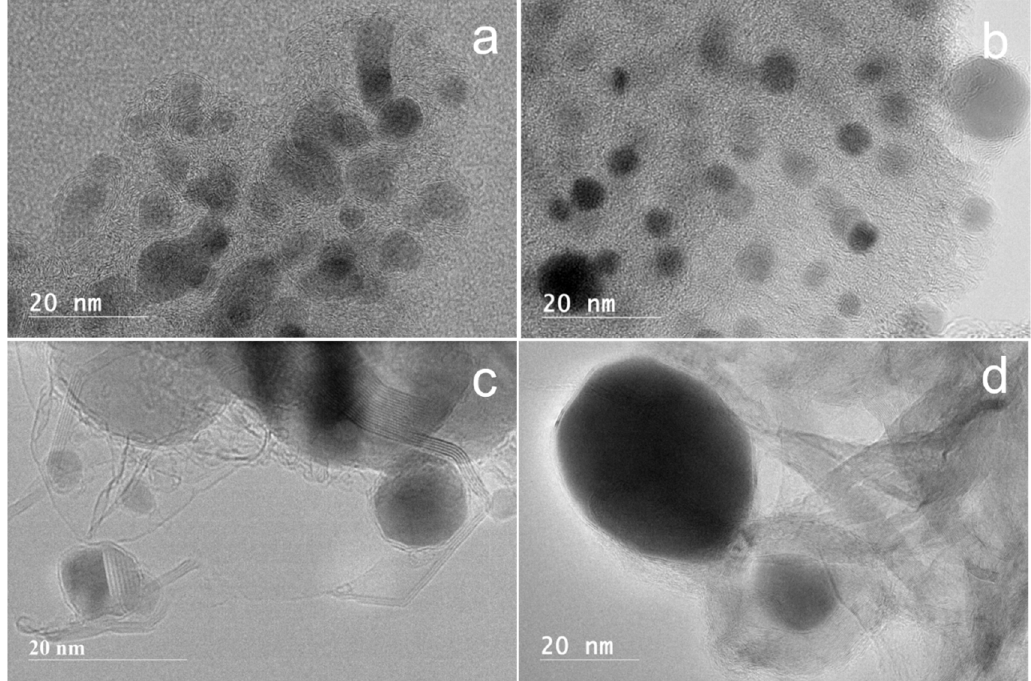
Figure 10. HRTEM images of the Ni@G samples after CDM reaction for 1 h at different reaction temperature: ( a ) 600, ( b ) 700, ( c ) 800, and ( d ) 900 °C.